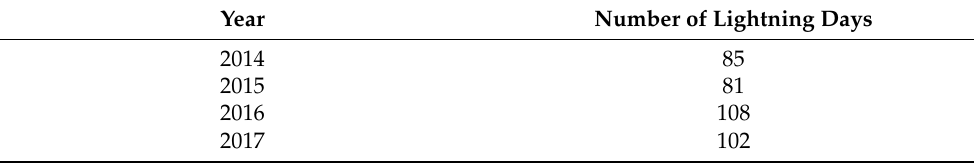
Table 1. Number of lightning days in each year void of geomagnetic storm and solar radiation effects.